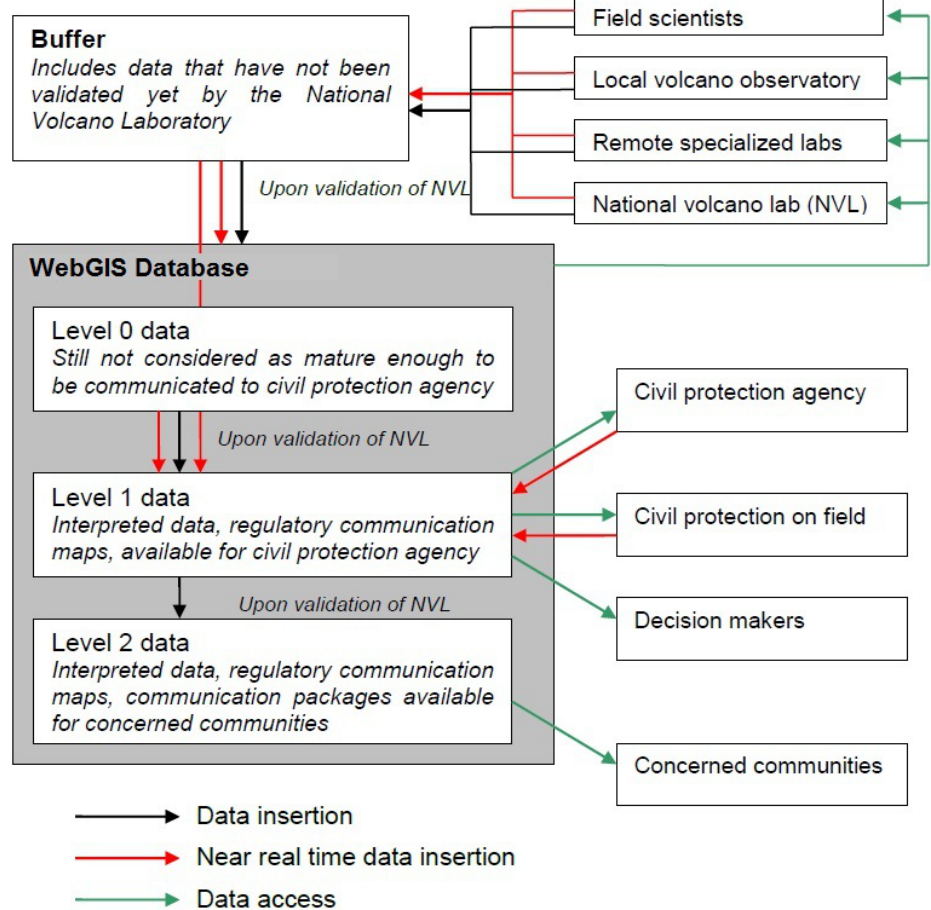
Figure 2. Use-case scheme of information flows between the database management system, data providers and users. This scheme shows the different possibilities for data insertion, validation and access. All data providers are also considered as potential users of the system. Here, a key role is given to the National Volcano Laboratory in managing the information flow.